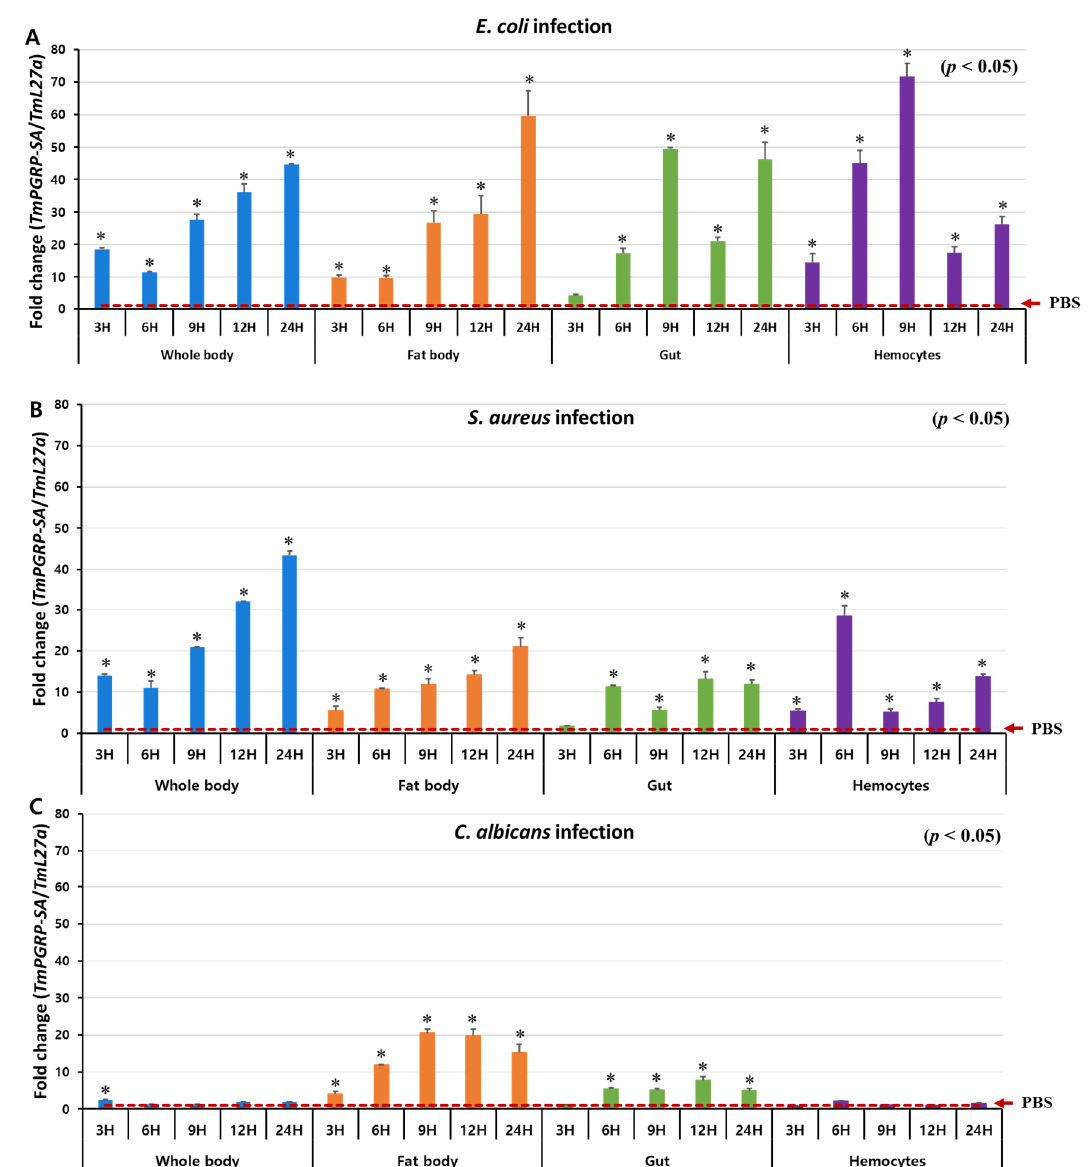
Figure 4. TmPGRP-SA is differentially induced following microbial challenges. Relative changes in gene expression (mean ± SE) of TmPGRP-SA in the whole body, fat body, gut, and hemocytes of T. molitor (10th–12th instar) larvae challenged with E. coli ( A ), S. aureus ( B ), and C. albicans ( C ) at the indicated time points by RT-qPCR ( n = 20 per treatment group per time point). TmPGRP-SA mRNA expression was normalized to the reference gene, T. molitor 60S ribosomal protein L27a ( TmL27a ), followed by normalization to the PBS-injected control mRNA expression. Statistical significance is denoted with asterisks ( p < 0.05).